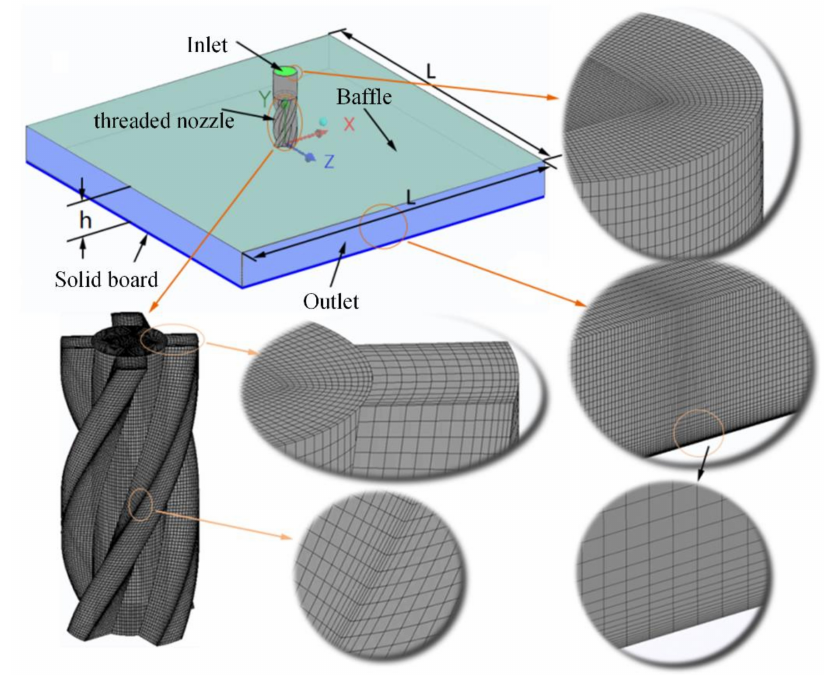
Figure 2. Mesh for numerical